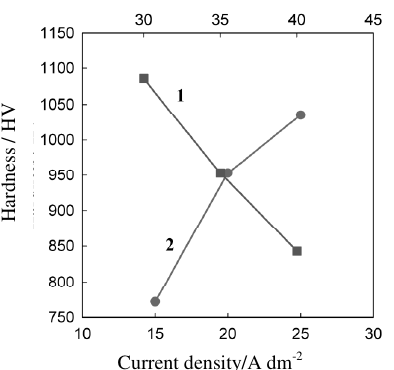
Figure 3. Dependences of chromium deposits hardness on bath temperature ( 1 ) and current density ( 2 ) basic bath composition ( 1 ) pH 1.5, current density 20 A dm -2 ; ( 2 ) pH 1.5, temperature 35 °